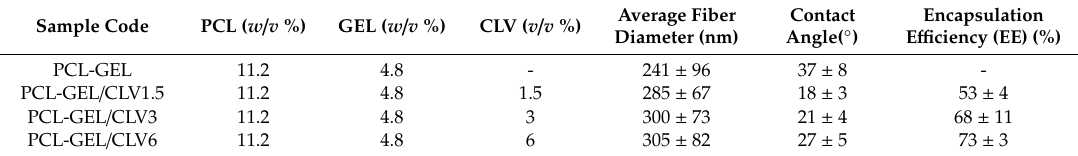
Table 1. Sample composition, sample label, average fiber diameter, and loading e ffi ciency of nanofiber mats.